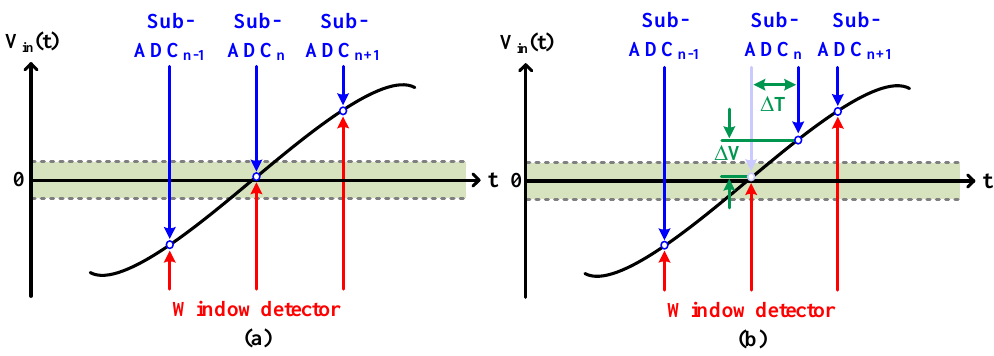
Figure 3. Concept of the window detector-based timing-skew calibration ( a ) without timing skew ( b ) with timing skew.